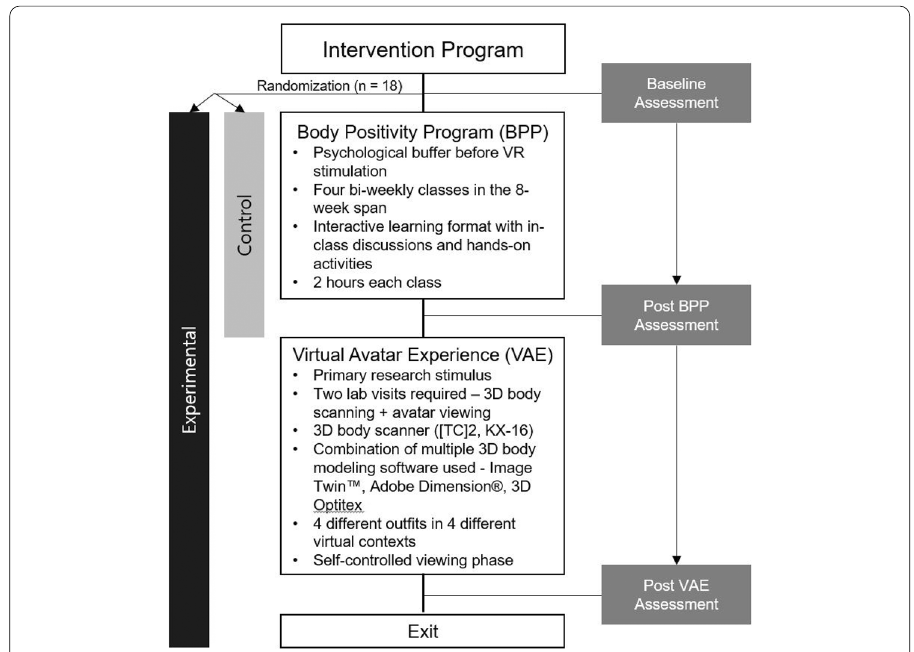
Fig. 1 Flow of the intervention program